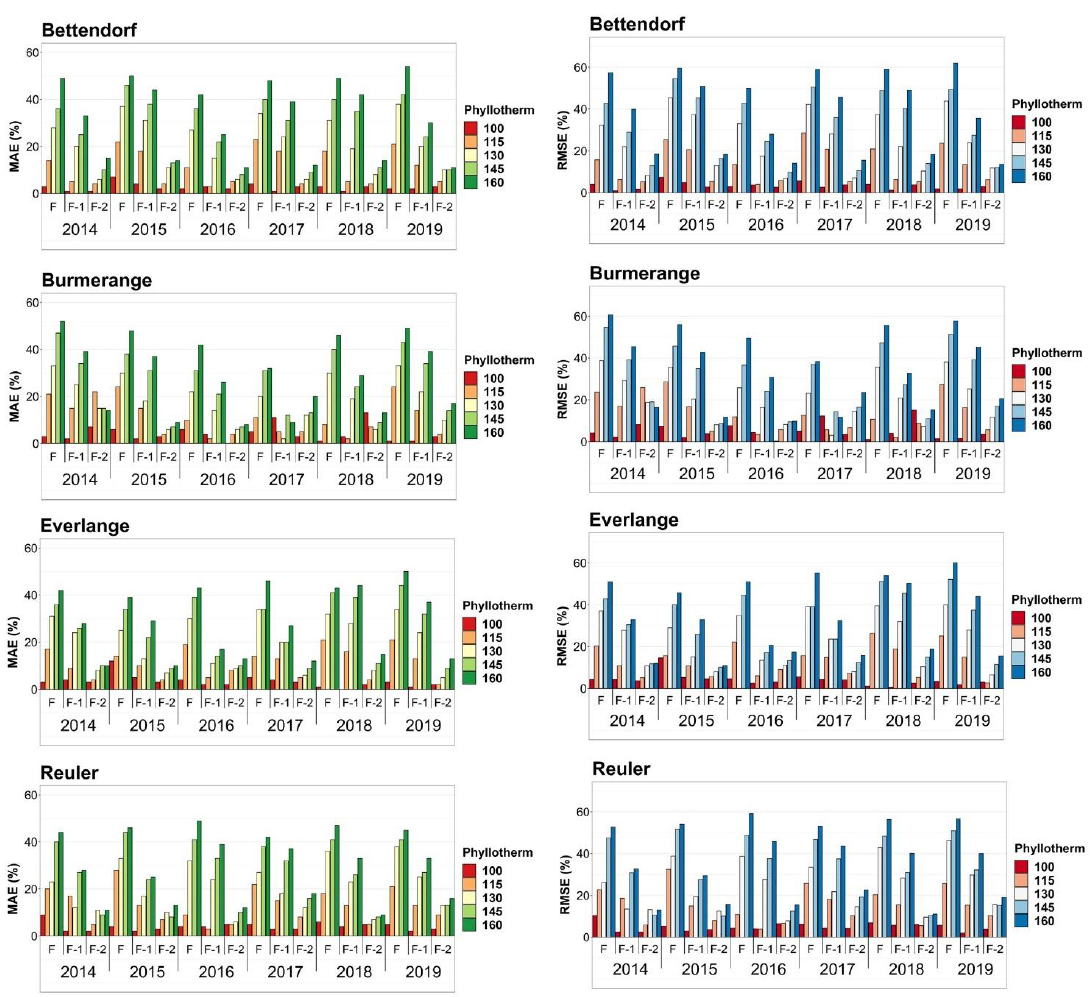
Figure 2. Mean absolute errors (MAE; left) and root mean square errors (RMSE; right) according to the phyllotherms used for predicting the emergence of leaves F, F-1 and F-2 in winter wheat in the Grand-Duchy of Luxembourg. Phyllotherms are expressed in °Cd. F is the flag leaf. In all years only values for the cultivar Kerubino were used.